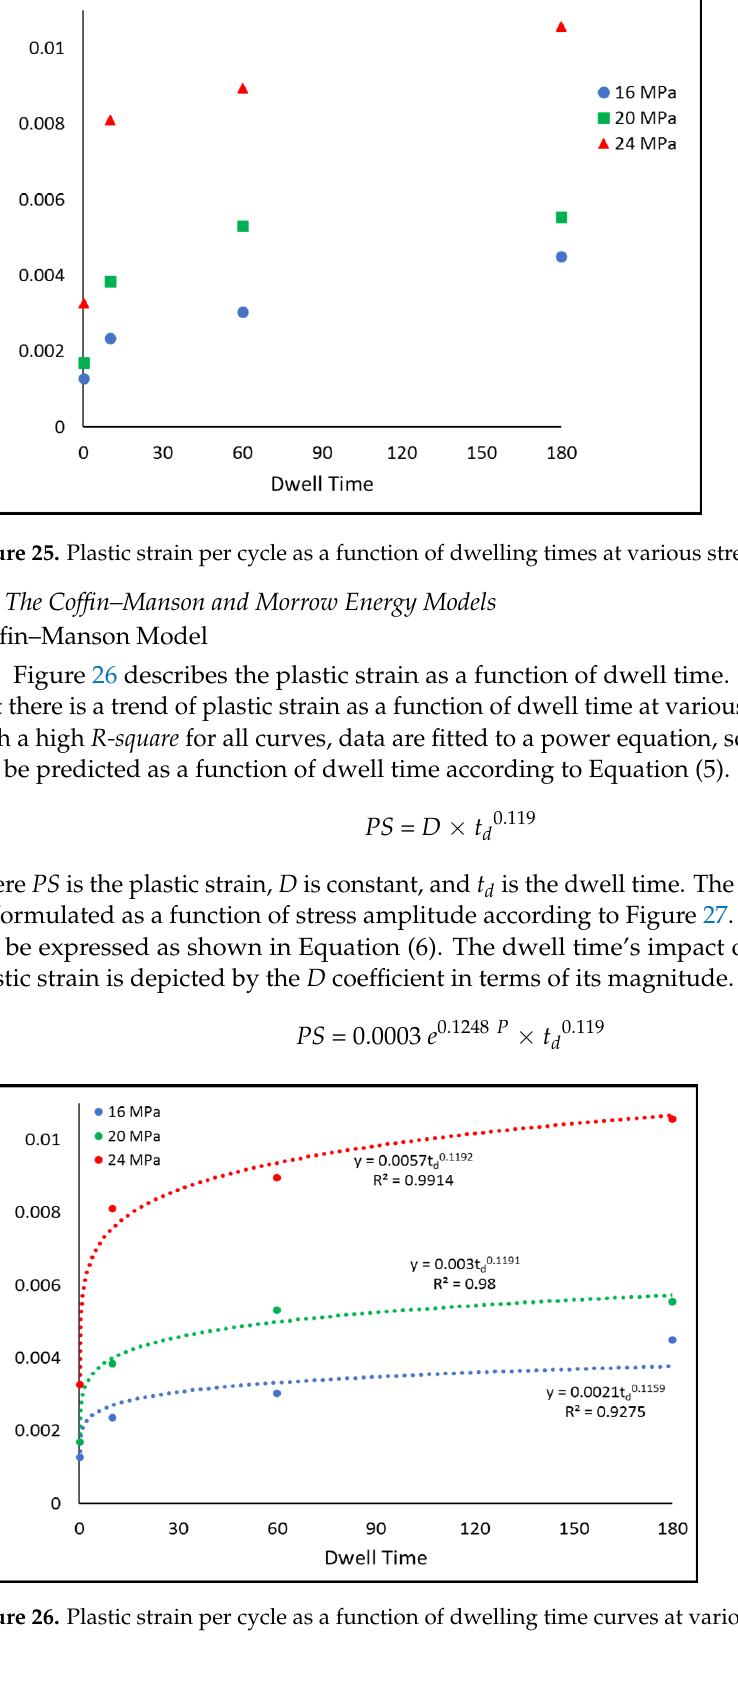
Figure 24. Average work per cycle as a function of dwelling times at various stress levels.